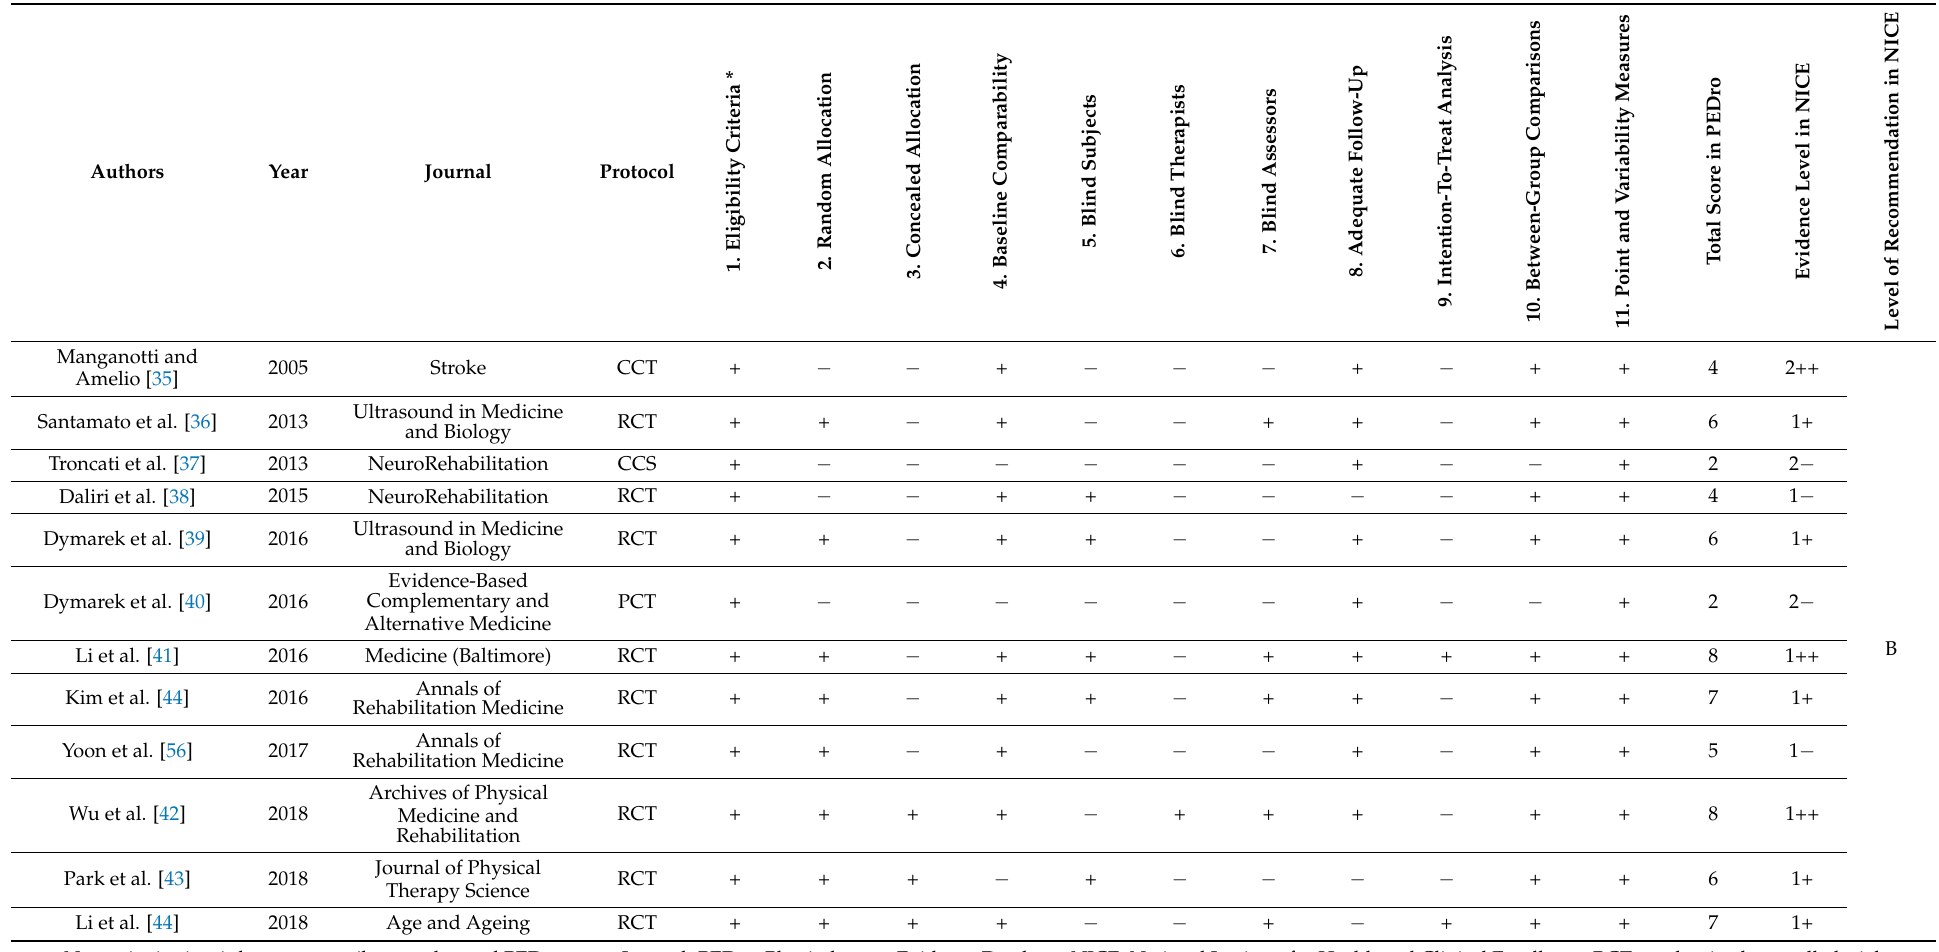
Table 3. Upper limb—methodological quality and level of evidence of